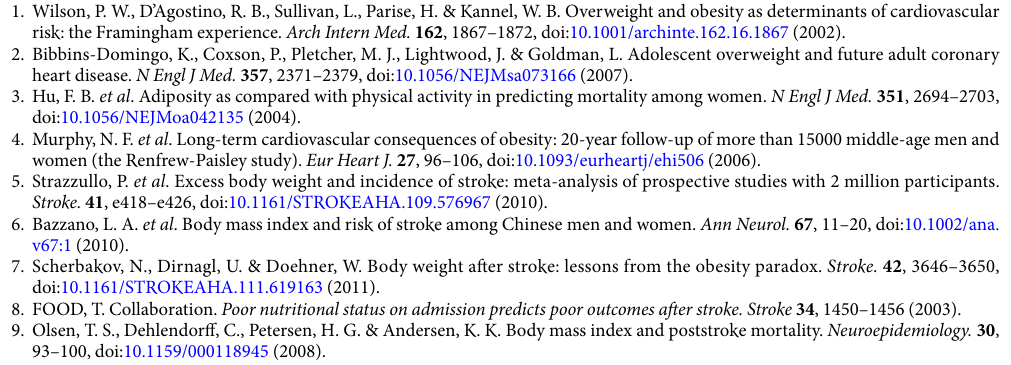
study. However, BMI does not reflect body fat distribution, which is also important to the evaluation of obesity 36 . Further studies with measures of body fat distribution, such as waist circumference or waist-to-hip ratio, may provide a more accurate assessment of the association between obesity and stroke outcome. In conclusion, the present study shows that there is no survival advantage of overweight or obesity after ischemic stroke. The risk of death and functional disability is not significantly different in overweight and obese patients as compared with normal-weight patients. Underweight is associated with the highest risk of death and high dependency after stroke. Our results support the rationality of weight control for overweight and obese patients recommended by current guidelines on secondary prevention of stroke. However, the observational nature of our study warrants further validation.